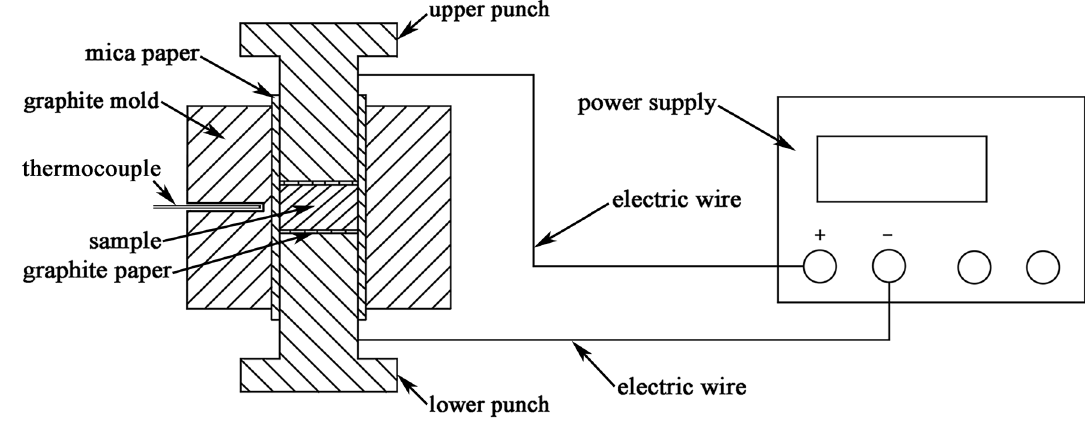
Figure 1. Schematic diagram of the FS